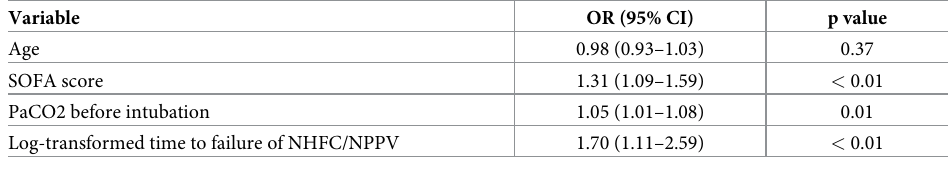
OR = Odds ratio; 95% CI = 95% confidence